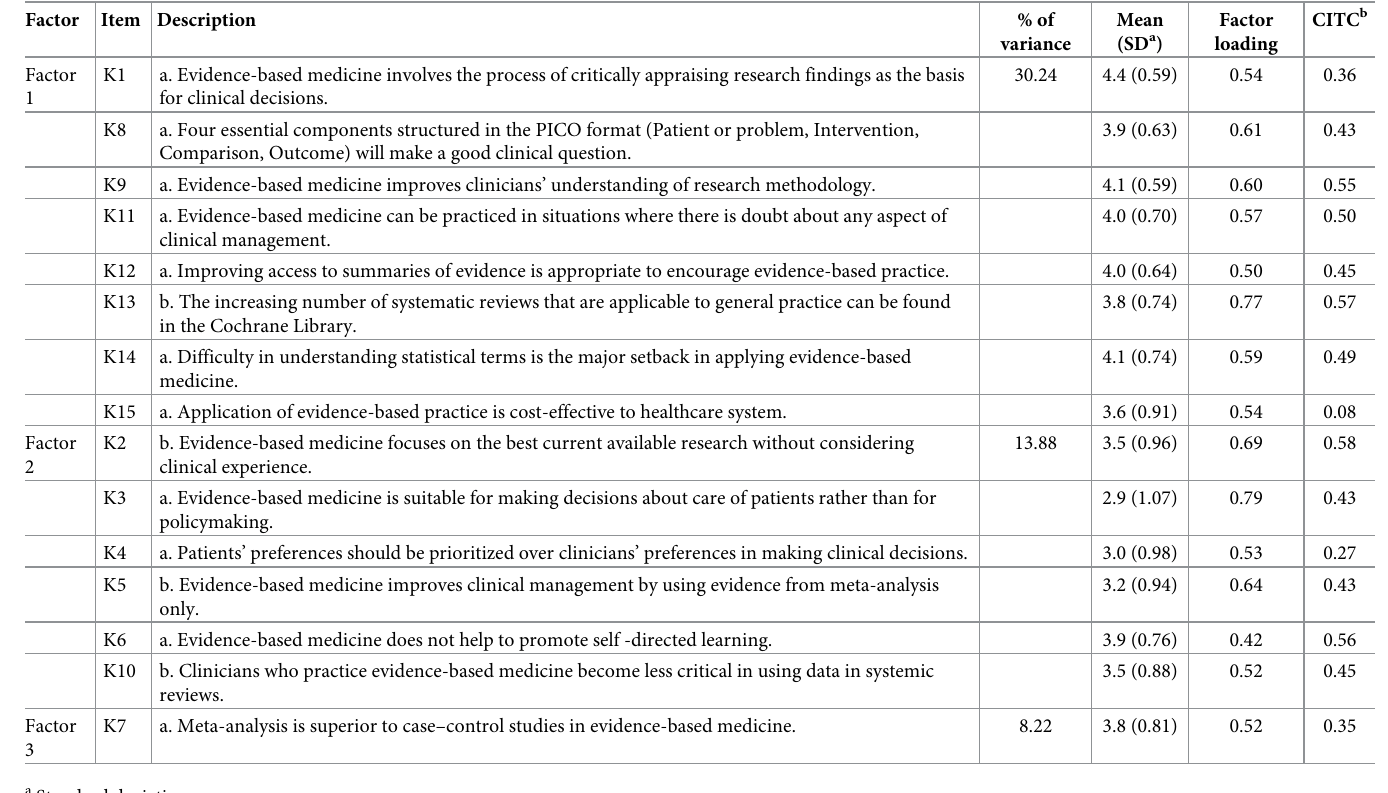
Table 1. Psychometric properties of the knowledge domain on